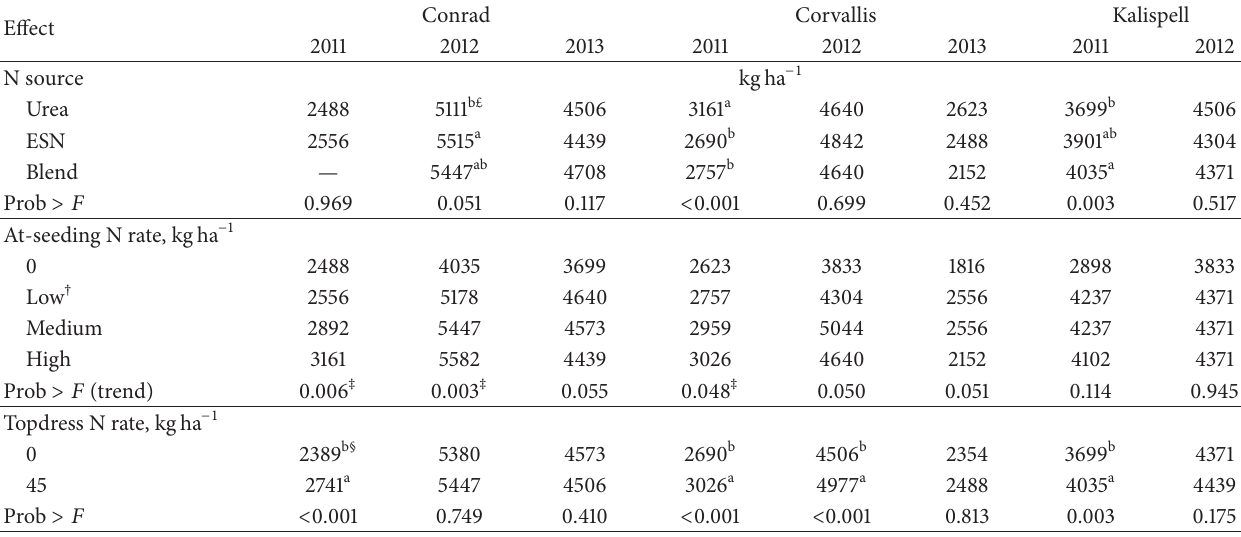
Table 2: Effect of N source and preplant and topdress N rate on spring wheat grain yield at Conrad, Corvallis, and Kalispell, MT, in 2011–2013 growing